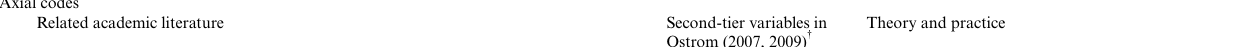
Theory and Ostrom (2007, 2009) †